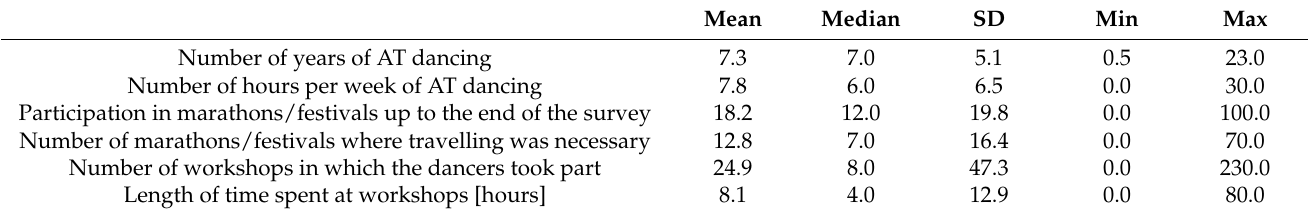
Table 2. Involvement in AT; SD—standard deviation, Min—minimum,